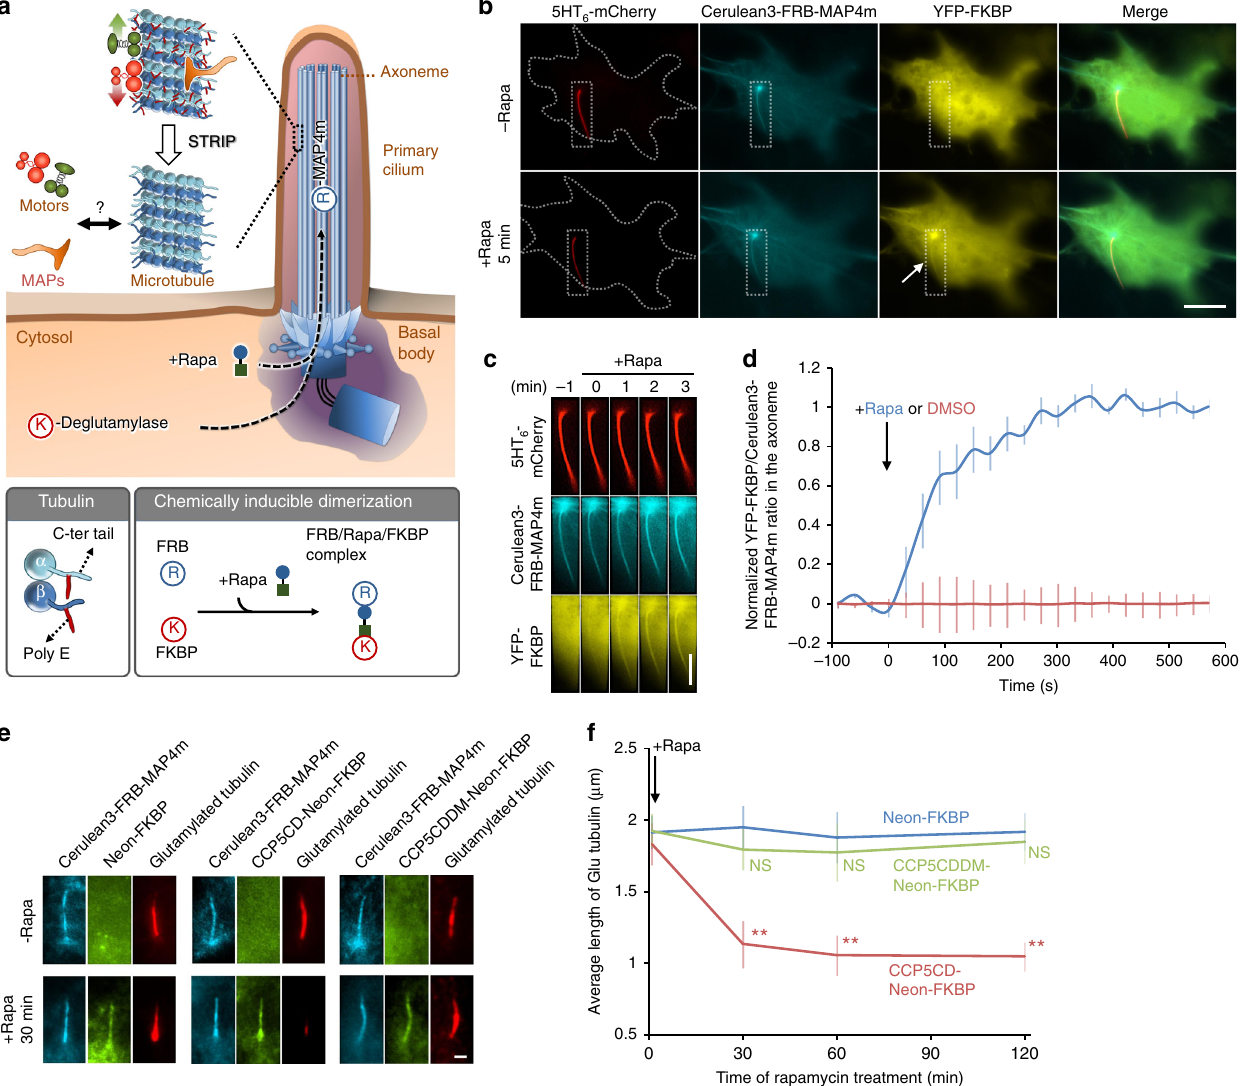
–0.200.20.40.60.811.2 Fig. 1 Spatiotemporally depleting tubulin glutamylation inside the cilia. a Schematic diagram of the STRIP (SpatioTemporal Rewriting of Intraciliary PTMs) approach which translocates an engineered deglutamylase from the cytosol onto ciliary axoneme using the chemically induced dimerization system. The cytosolic FKBP – deglutamylase can be recruited to the FRB – MAP4m-labeled axoneme by adding rapamycin ( + Rapa). The causal relationship among the axonemal glutamylation, motors, and MAPs (microtubule-associated proteins) will be evaluated. b The addition of 100 nM rapamycin induces the accumulation of YFP – FKBP onto the Cerulean3 – FRB – MAP4m-labeled axoneme (arrow) in NIH3T3 cells. Transfected cells at 80 – 90% con fl uency were serum-starved for 24 h and then incubated with 100 nM rapamycin for the indicated times. Scale bar, 10 μ m. c Individual video frames in the axoneme region of cells in b upon 100 nM rapamycin treatment. Scale bar, 5 μ m. Also, see Supplementary Movie 1. d Time course of YFP fl uorescence intensity in the axoneme of NIH3T3 cells treated with 100 nM rapamycin (blue) or 0.1% DMSO (red). Data represent the mean ± s.e.m. ( n = 10 cells for DMSO group, n = 8 cells for rapamycin group; four independent experiments). e, f Translocation of CCP5CD-Neon-FKBP to the axoneme reduces axonemal glutamylation. NIH3T3 cells were transfected with P2A-based constructs for co-expression of Cerulean3 – FRB – MAP4m and Neon-FKBP-tagged proteins. Transfected cells at 80 – 90% con fl uency were serum-starved for 24 h and then incubated with 100 nM rapamycin for the indicated times. The level of axonemal glutamylation in cells expressing the indicated proteins was assessed by labeling with anti-glutamylated tubulin antibody and quantifying before and after the addition of 100 nM rapamycin. Scale bar, 1 μ m. Data represent the mean ± s.e.m. ( n = 276, 299, and 244 cells for the Neon-FKBP, CCP5CD- Neon-FKBP, and CCP5CDDM-Neon-FKBP groups, respectively; 3 – 5 independent experiments). NS and ** indicate no signi fi cant difference and P < 0.01, respectively, between the control (Neon-FKBP) and the indicated groups (Student's t -test) method, we next tested the MAP4m approach with a gibberellin- these fusion proteins led to accumulation of the neon fl uorescence signal at the ciliary axoneme (Supplementary Fig. 2; based CID that works orthogonally to the rapamycin-based CID 41 . Here, we constructed two fusion proteins: a codon- Supplementary Movie 2), albeit with slower kinetics optimized gibberellin insensitivity DWARF1 (mGID1) fused to (127.3 ± 25.9 s) compared with the rapamycin-based CID neon (Neon-mGID1), and MAP4m fused to an N-terminal 92 (Supplementary Fig. 2c). Taken together, these results con fi rmed amino acids of gibberellin insensitive (GAIs – CFP – MAP4m). The that the CID systems utilizing MAP4m can relocate cytosolic addition of a gibberellin analog (GA 3 -AM) to cells coexpressing proteins onto the ciliary axoneme of living cells within minutes. | DOI: 10.1038/s41467-018-03952-z |